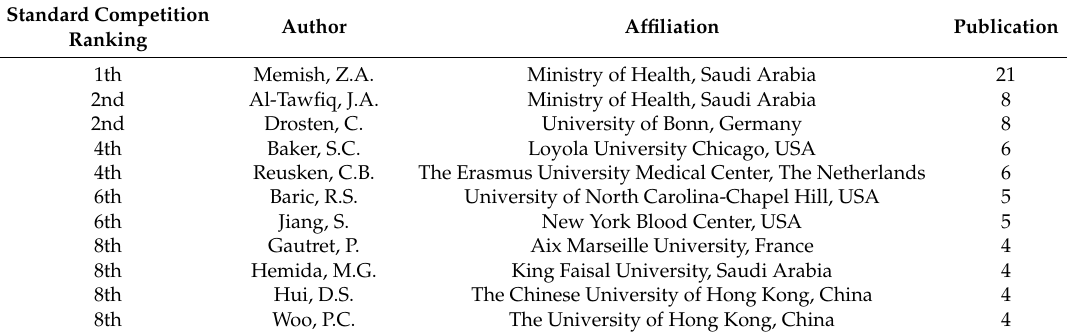
Table 5. Ten most productive corresponding authors with MERS articles during the period from 2012 to 2015.